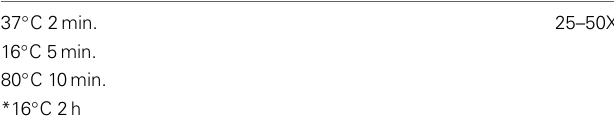
Table 3 | PCR cycling parameters for Golden Gate Cloning reaction where BsaI site(s) exist within the insert fragment(s).